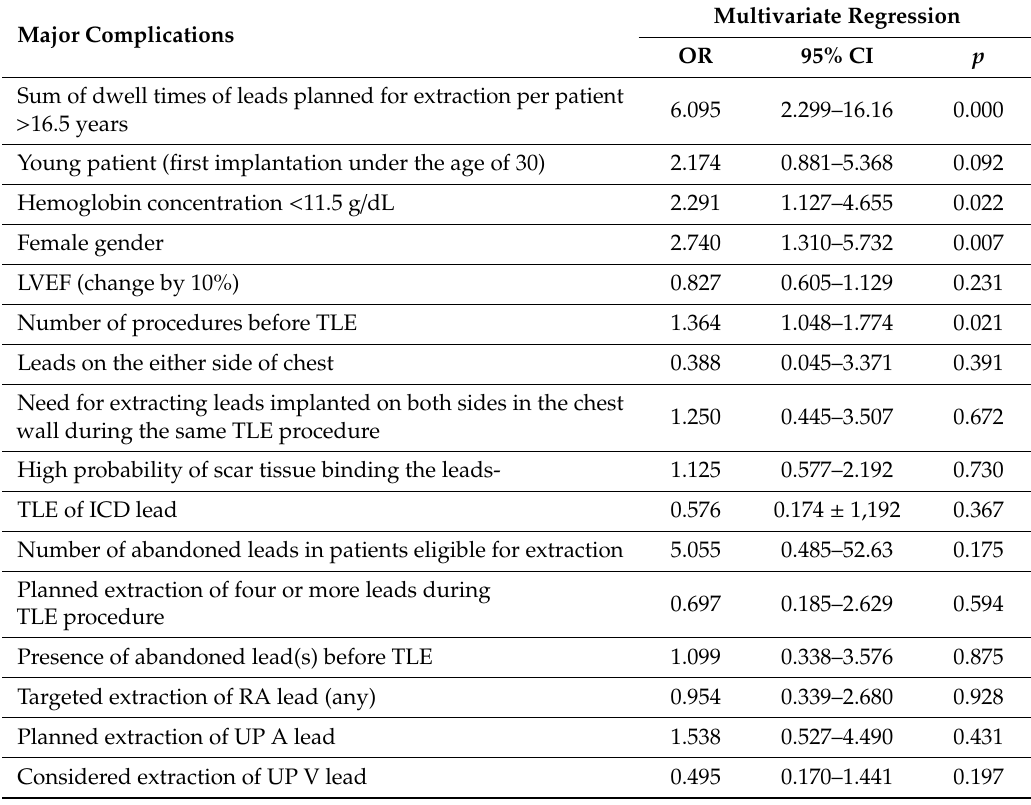
Table 2. Multivariate analysis of major complications.